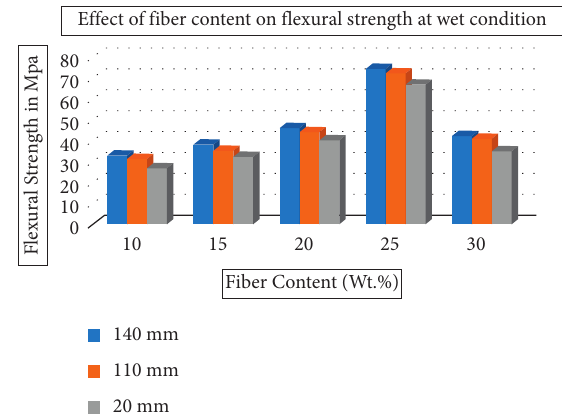
Figure 9: Flexural behavior in dry and wet conditions with varying fiber